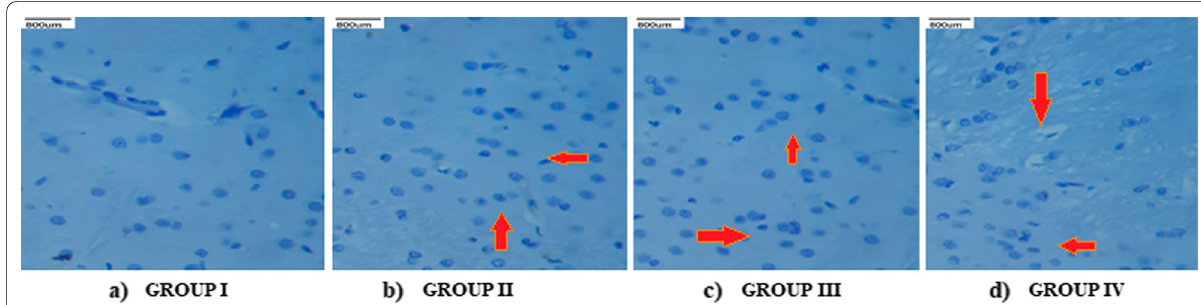
Fig. 7 Representative photomicrographs of CD-68 expression on dorsal hippocampus of rats received ICV infusions of PBS or PPA for 7 days. a